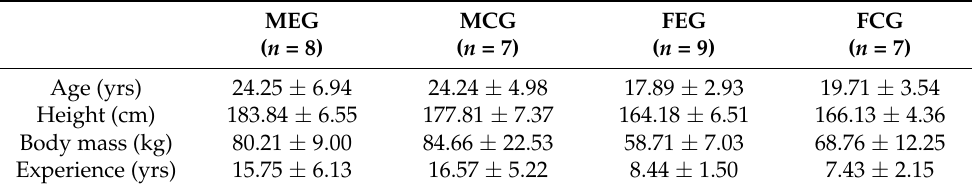
Table 1. Player characteristics by